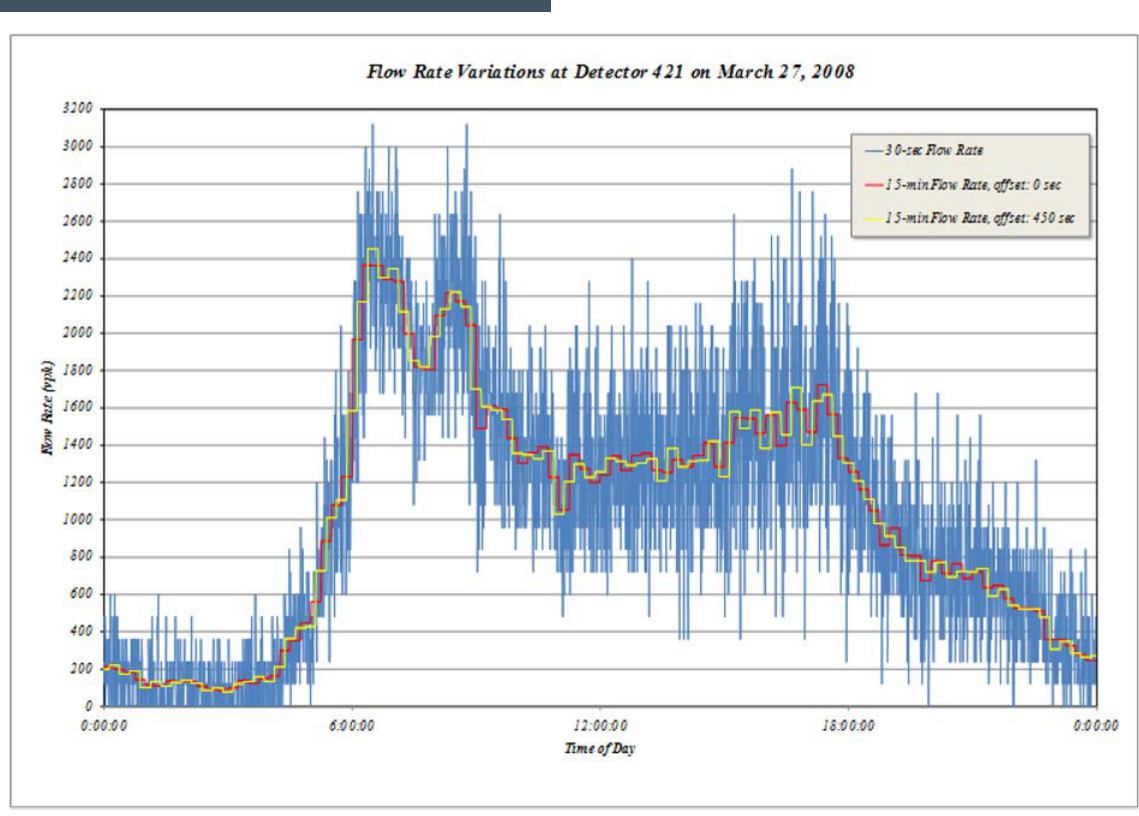
Figure 1. 30-second and 15-minute Flow Rates from Real Data